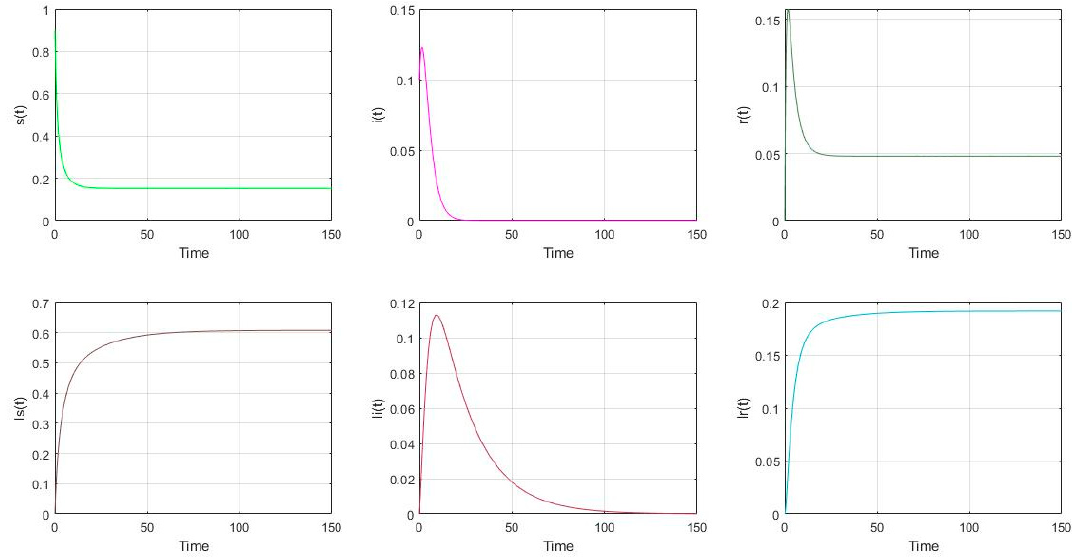
Figure 2. The distribution of nodes if R 0 = 0.3149 and β 2 = 0 .